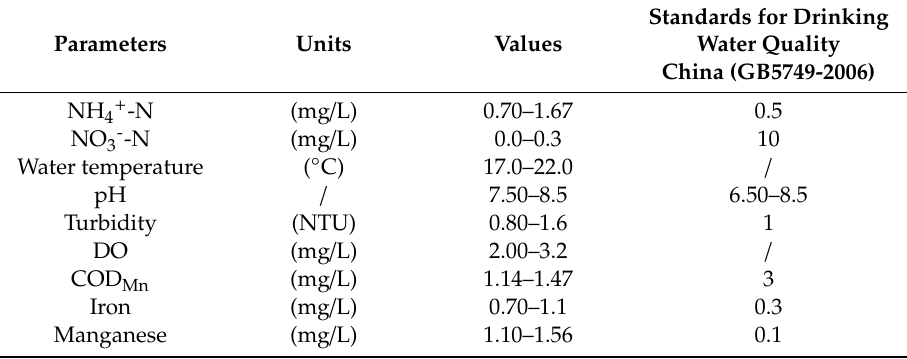
Figure 1. Schematic of the pilot-scale filter. Table 1. Water quality of the raw water (groundwater) used in the pilot-scale filter system.